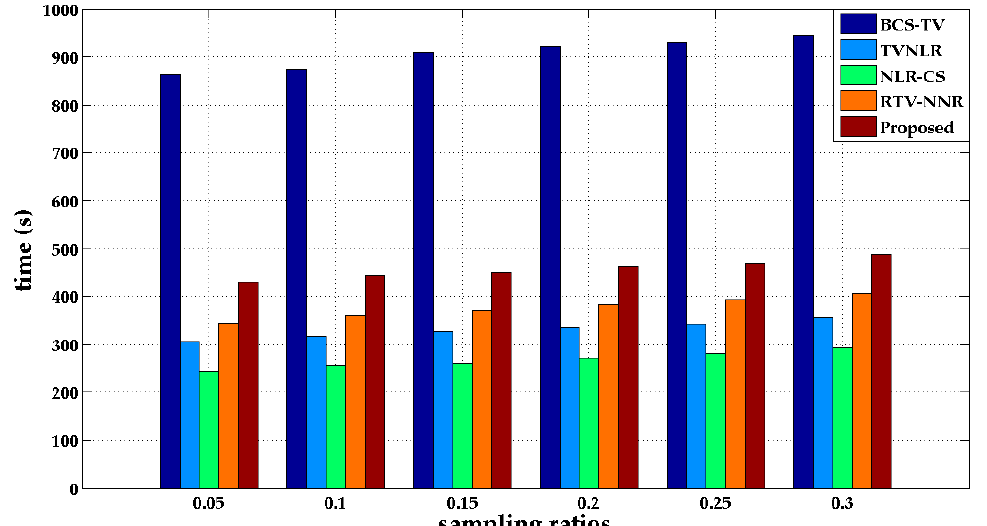
Figure 10. Average reconstruction time of five algorithms with different ratios.